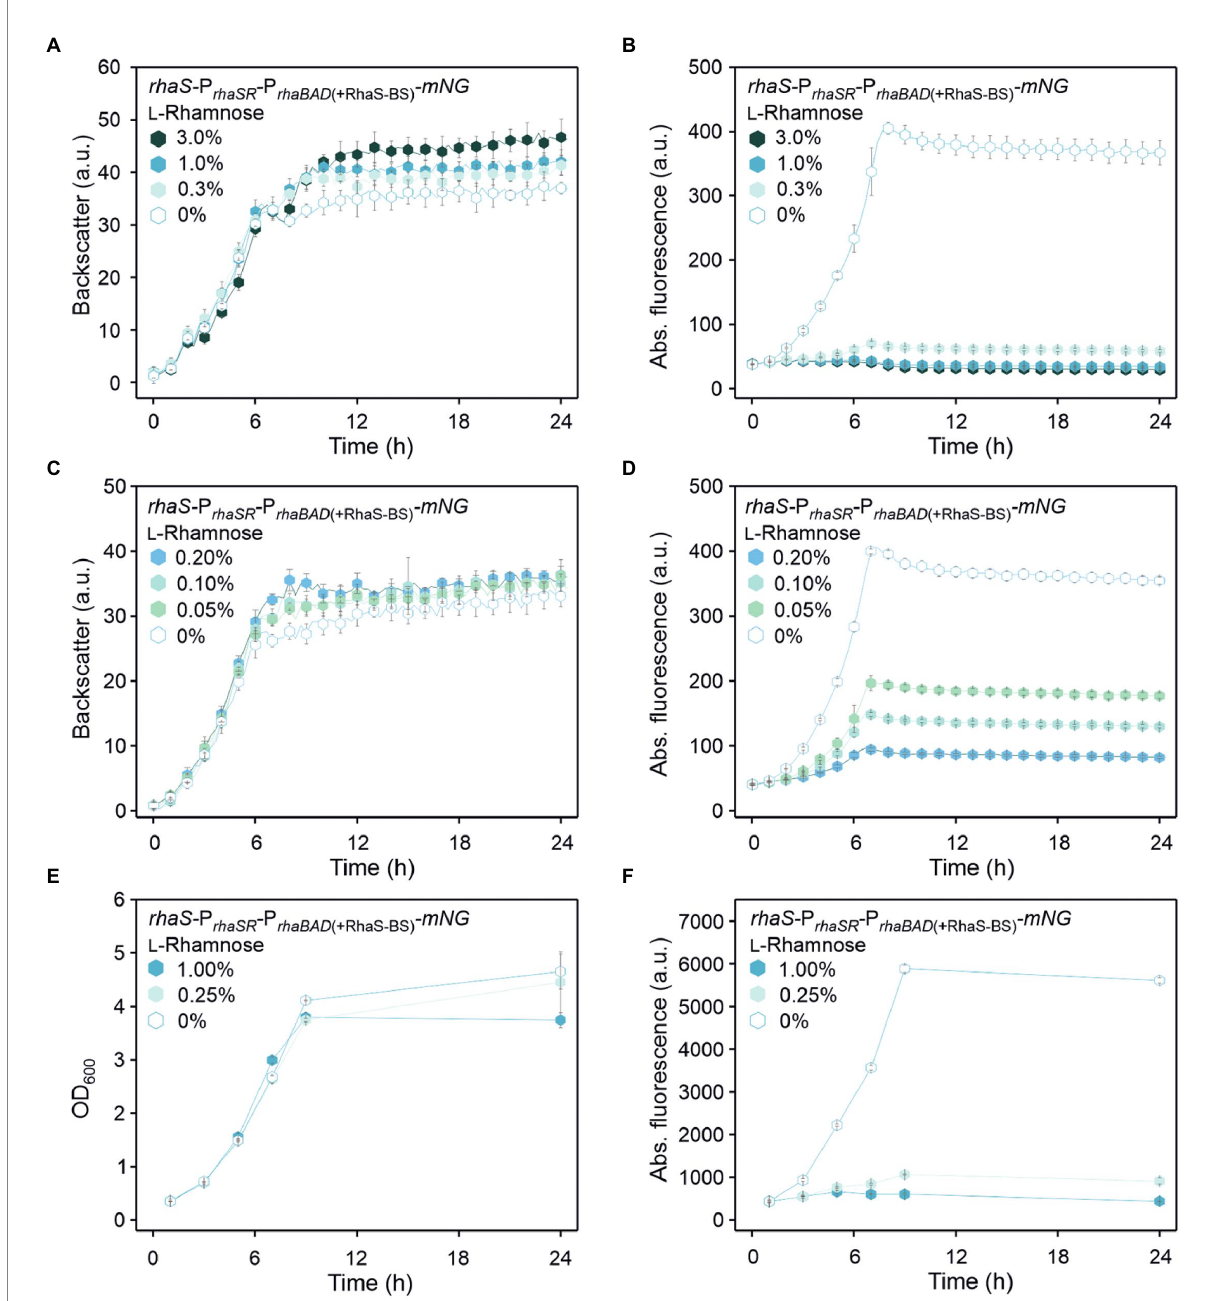
FIGURE 5 Tunability of the RhaS-P rhaBAD (+RhaS-BS) system in G. oxydans 621H carrying plasmid pBBR1MCS-5- rhaS -P rhaSR -P rhaBAD (+RhaS-BS) - mNG . (A,C) Growth in d -mannitol medium according to backscatter and (B,D) absolute mNG fluorescence in BioLector cultivations. l -Rhamnose was supplemented in concentrations ranging from 0.05 to 3% (w/v). All data represent mean values and standard deviation from two biological replicates (clones) with three technical replicates each. BioLector settings: backscatter gain 20, fluorescence gain 40. (E) Growth in d -mannitol medium and (F) absolute mNG fluorescence in shake flasks. The mNG fluorescence was measured in a Tecan reader (gain